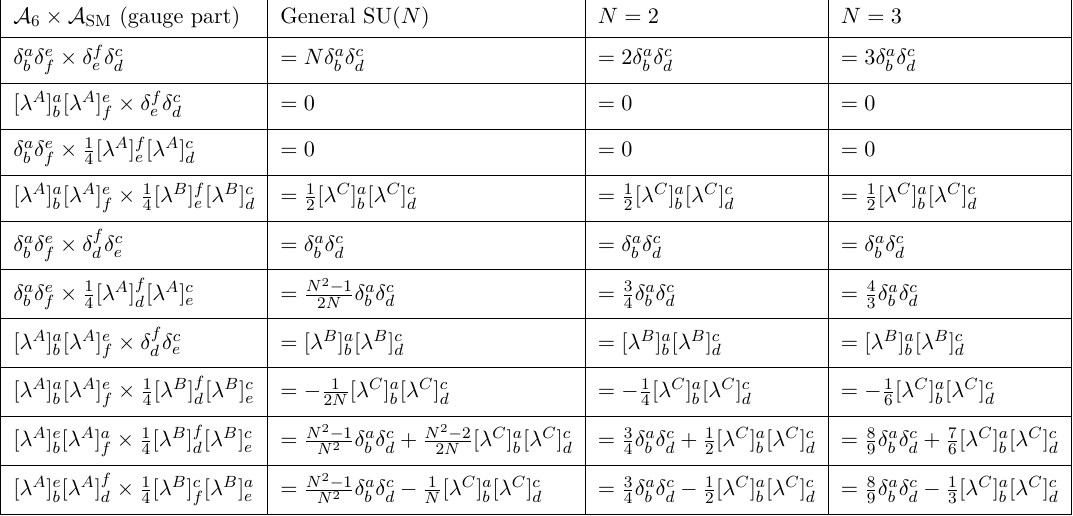
Table 2 . Possible gauge contractions appearing in A 6 × A SM . The identities are valid for SU( N ) generators λ A normalised such that Tr[ λ A λ B ] = 2 δ AB , and which reduce to the Pauli (Gell-Mann) matrices when N = 2 (3)